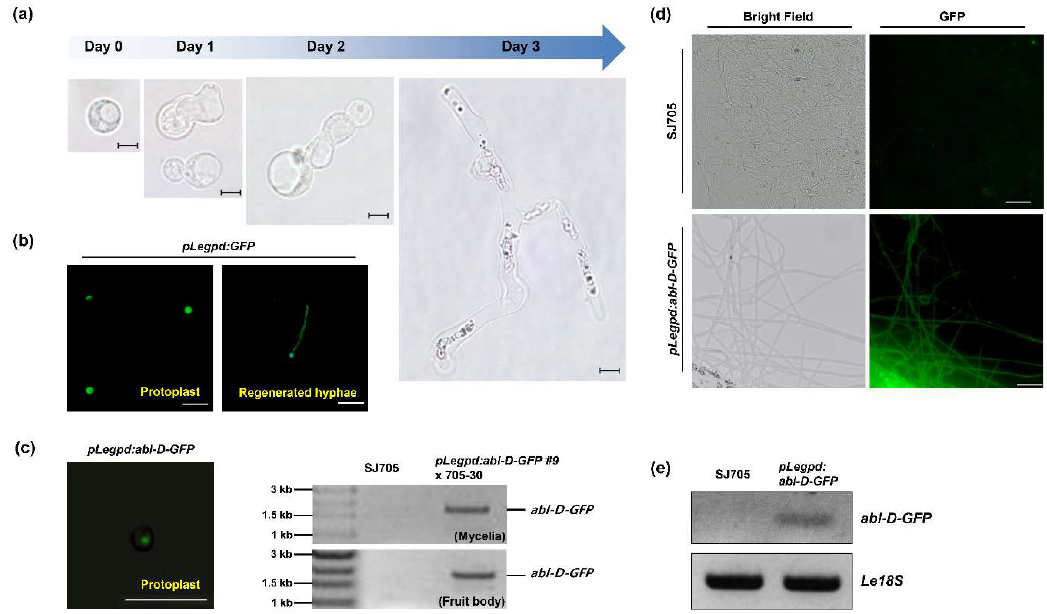
Figure 3. Generation of monokaryotic strains overexpressing abl - D -GFP by protoplast transformation ( a ) Regeneration of L . edodes protoplasts. Scale bar = 10 µm. ( b ) Stable expression of GFP under the control of the native Legpd promoter. GFP fluorescence was observed at 15 h (Protolast) and 3 days (Regenerated hyphae) after transformation. Scale bar = 50 µm. ( c – e ) Expression analysis of the abl - D -GFP transgene. GFP fluorescence was observed in protoplasts (( c ), left) and regenerated hyphae ( d ). Scale bar = 50 µm. PCR amplification of the transgene from the genomic DNA of transgenic mycelia and fruit bodies (( c ,) right), and from cDNA derived from the mRNA of transgenic mycelia ( e ).